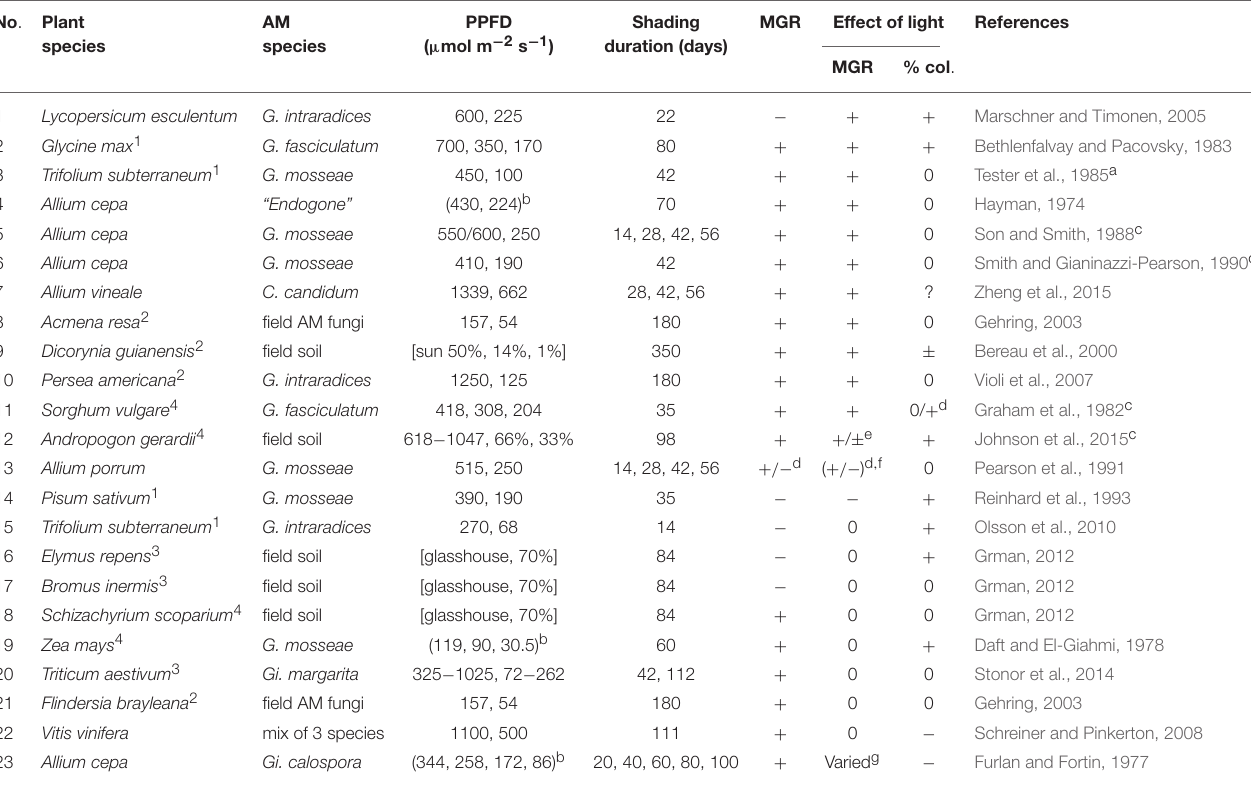
TABLE 1 | Synthesis of previously published literature on the effects of experimentally manipulated light intensities on the mycorrhizal growth response (MGR). No .